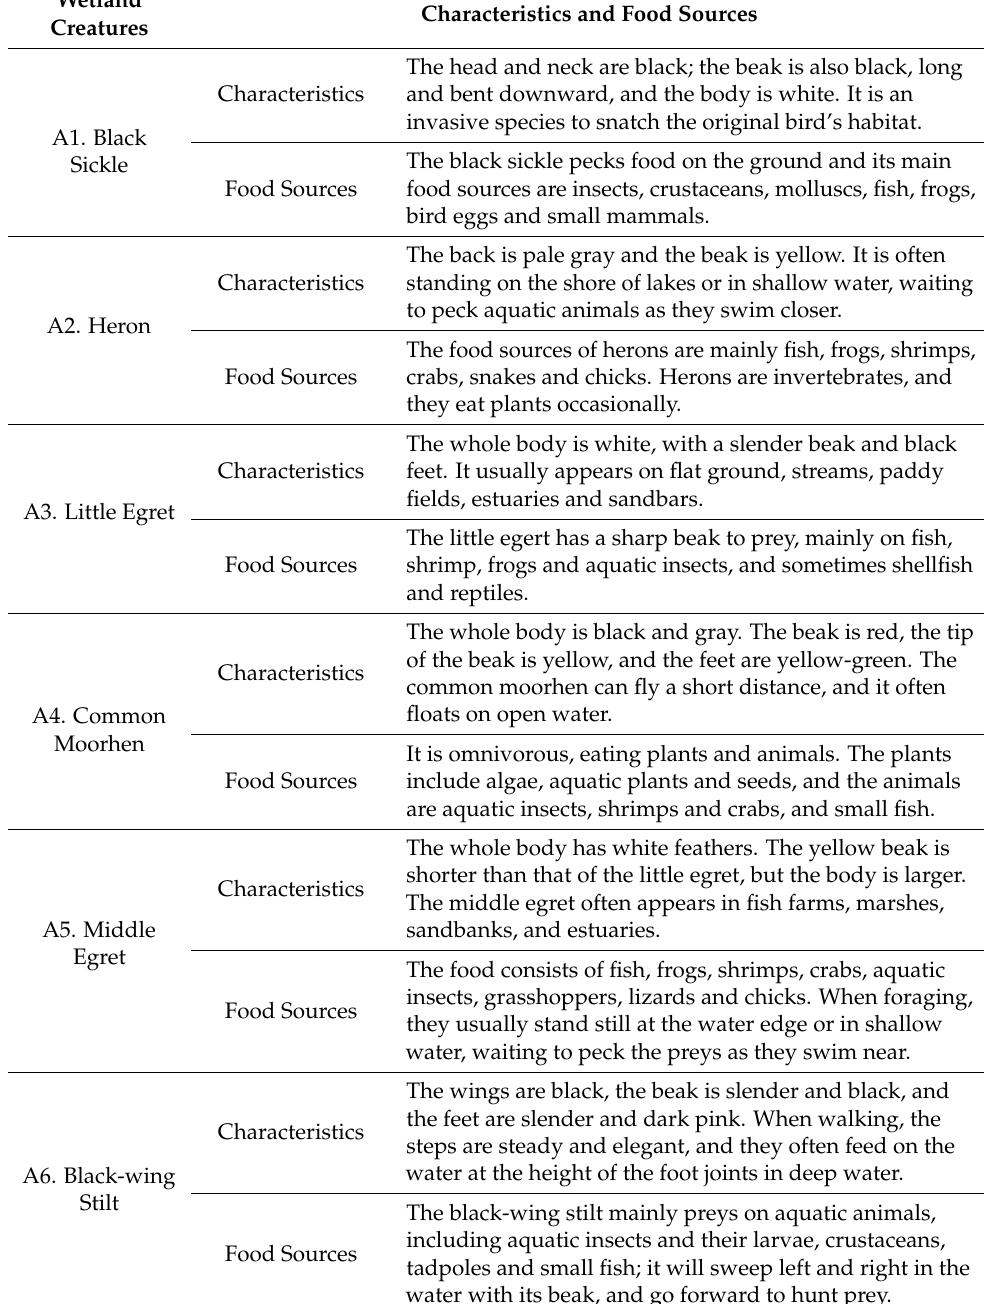
Table 2. Chin Cheng Lake bird-watching area and its creatures’ characteristics and food